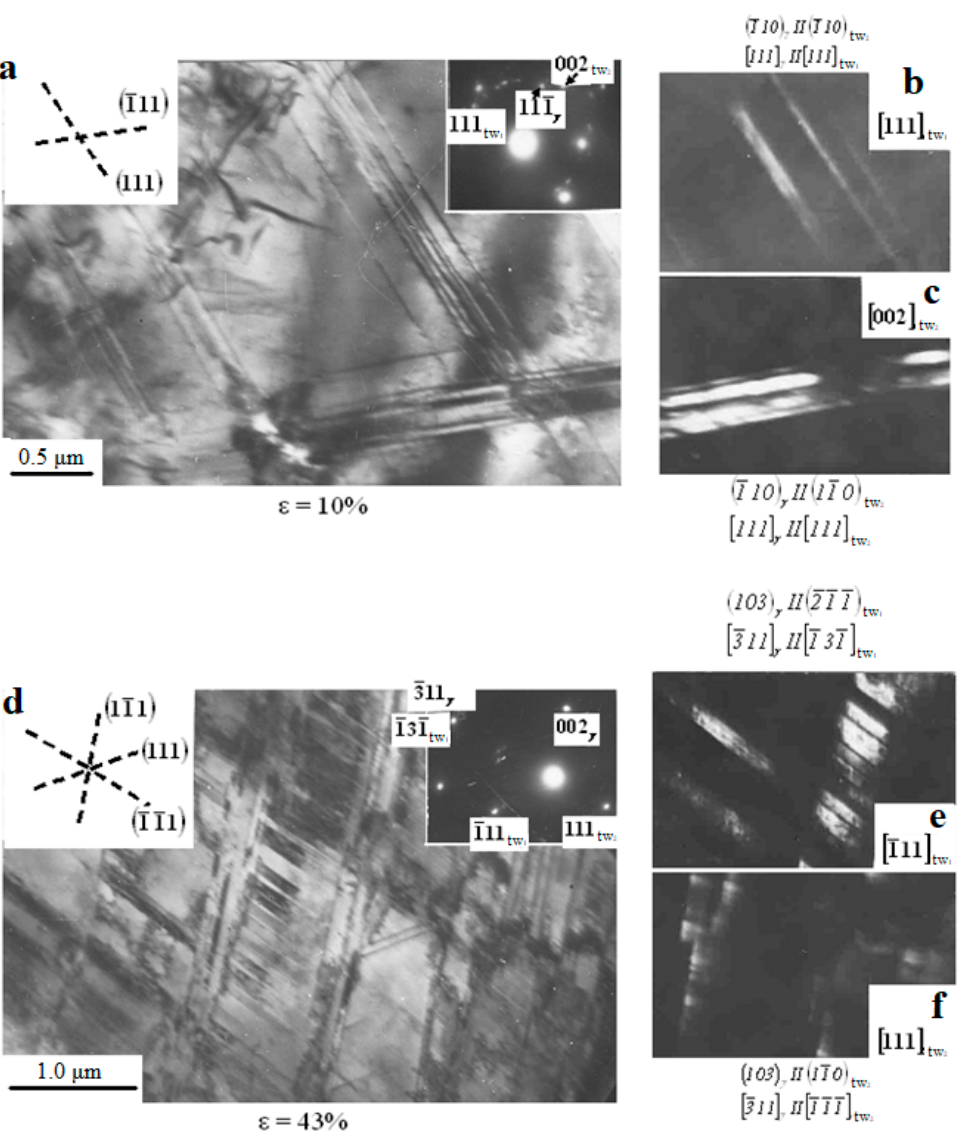
Figure 7. TEM micrographs of intersecting systems of microtwins in Hadfield steel after deformation ( ε = 10%): the bright field—with electron diffraction pattern, where the arrows show the reflections of the γ -matrix and twins ( a ); the dark field is obtained in the reflections of twins [111] ( b ) and [002] ( c ); after deformation with ε = 43%, the bright field—with electron diffraction pattern ( d ), the dark field is obtained in the reflections of twins [ 1(cid:3364)11 ] ( e ) and [111] ( f ).